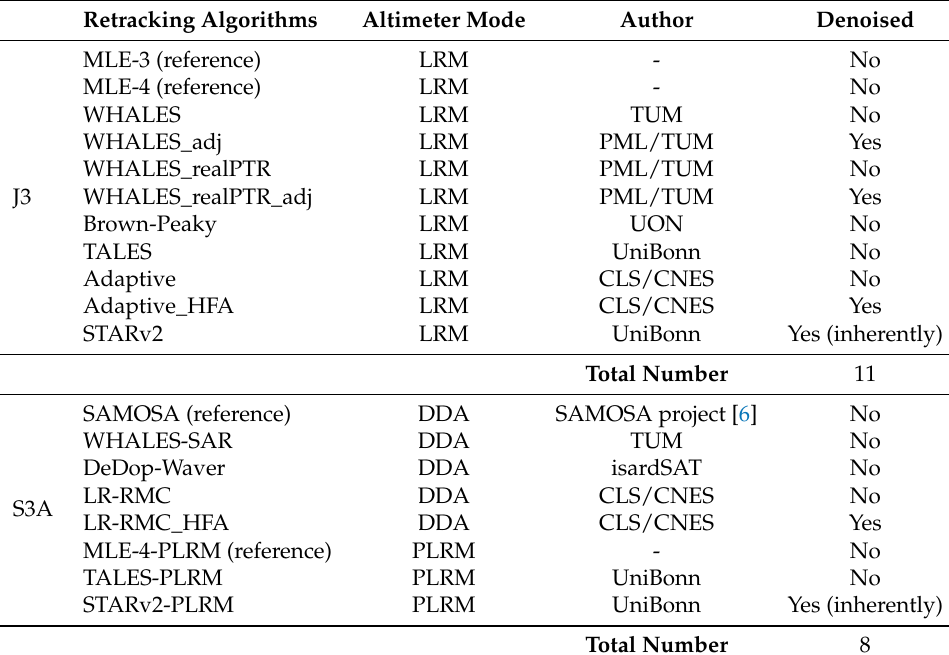
Table 3. Investigated Low Resolution Mode (LRM) and DDA retracking